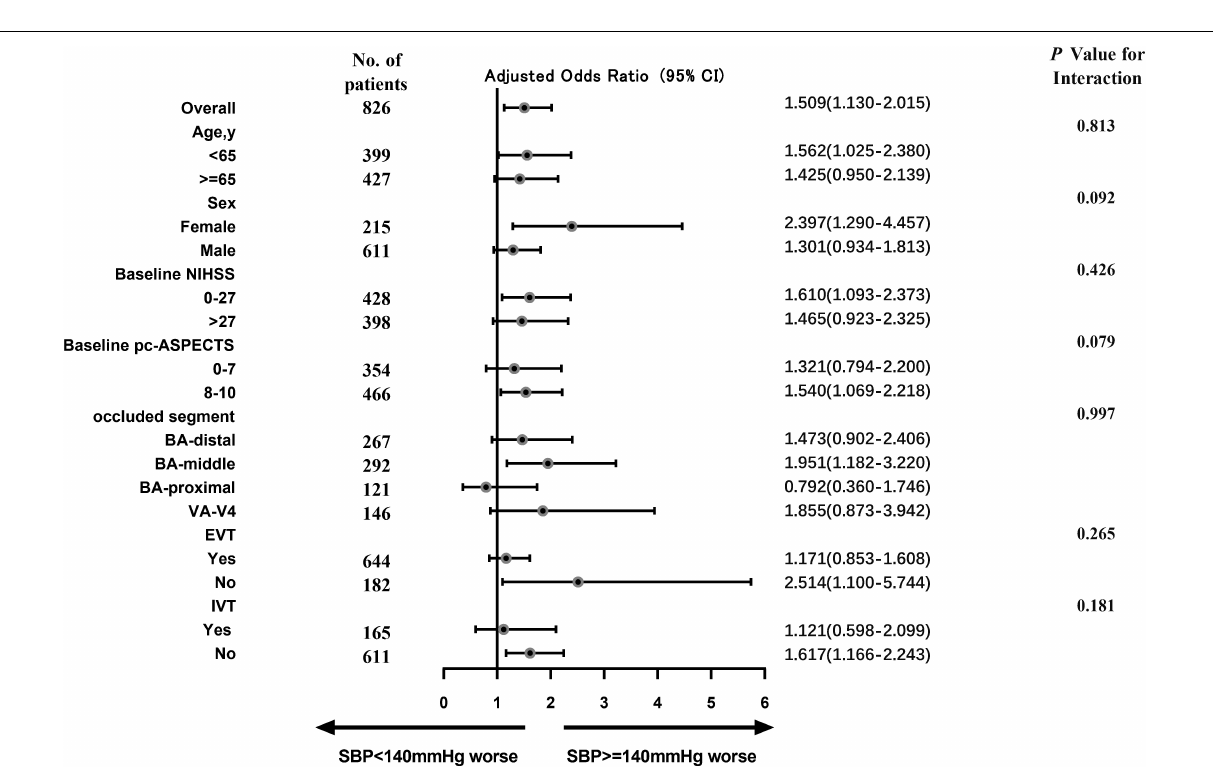
Frontiers in Neuroscience |